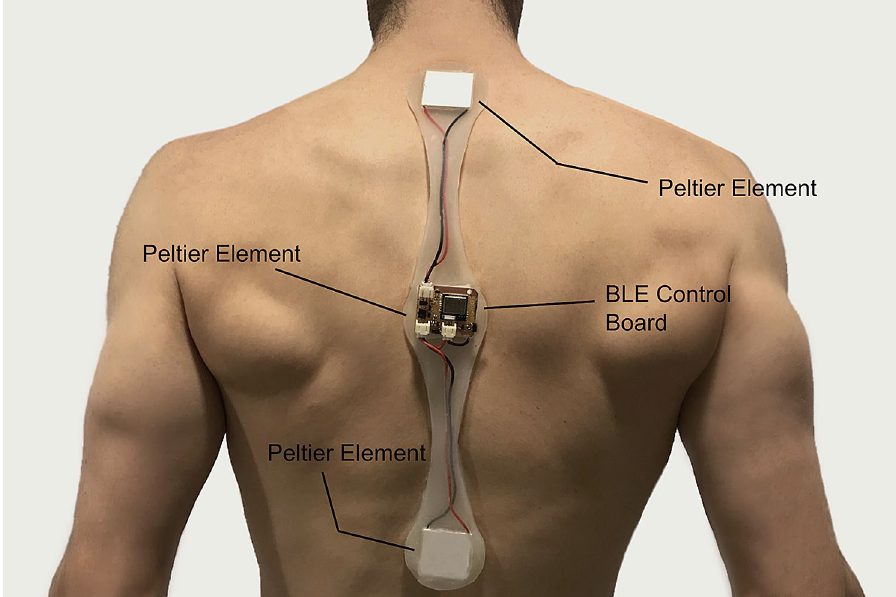
Figure 5. The Frisson prosthesis: a device delivering thermal feedback in a manner closely resembling to the internal chill, a traversing cold temperature from top to